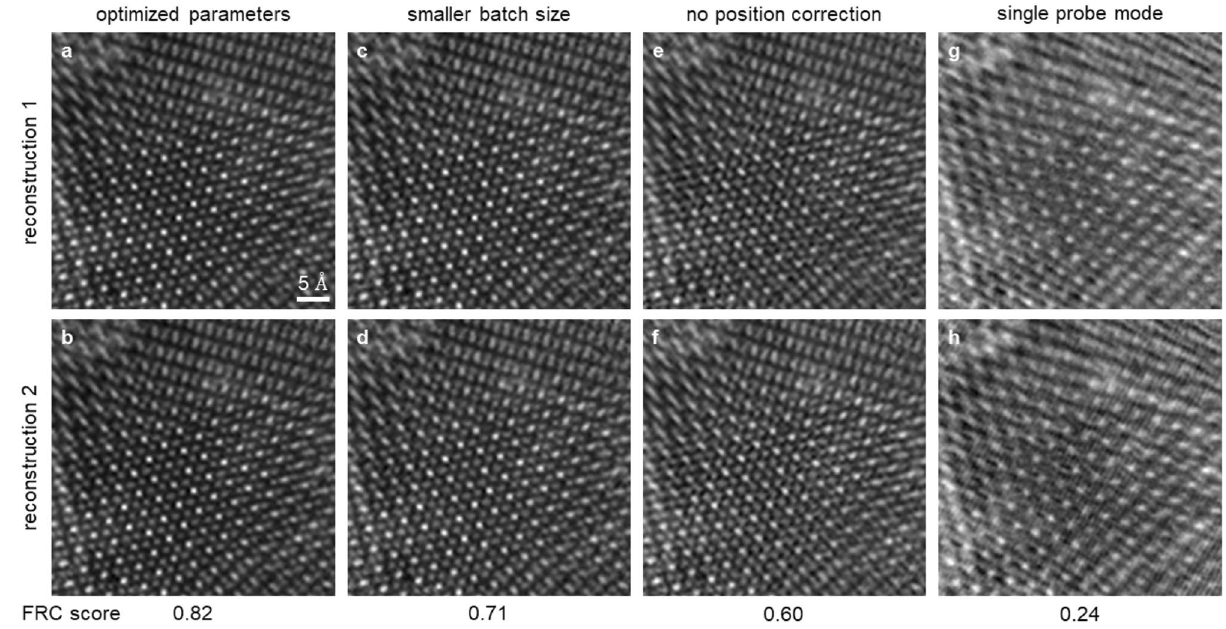
Figure 3. Optimized ptychographic reconstructions of bilayer MoSe 2 /WS 2 compared with sub-optimal parameters. Two datasets that cover the same scan area were reconstructed independently for 5 min using the LSQ-ML technique. ( a , b ) Reconstructed phase with the parameters optimized by Bayesian optimization, including 7 mixed-state probe modes, a batch size of 300, and scan position correction. ( c – h ) Reconstructions where one of the optimal parameters is changed. All sub-optimal parameter combinations decrease the reconstruction quality to varying degrees. ( c , d ) Reconstructions with a batch size of 60, which increases the time per iteration, and reduces the total number of iterations. ( e , f ) Reconstructions without position correction. ( g , h ) Reconstructions with a single probe